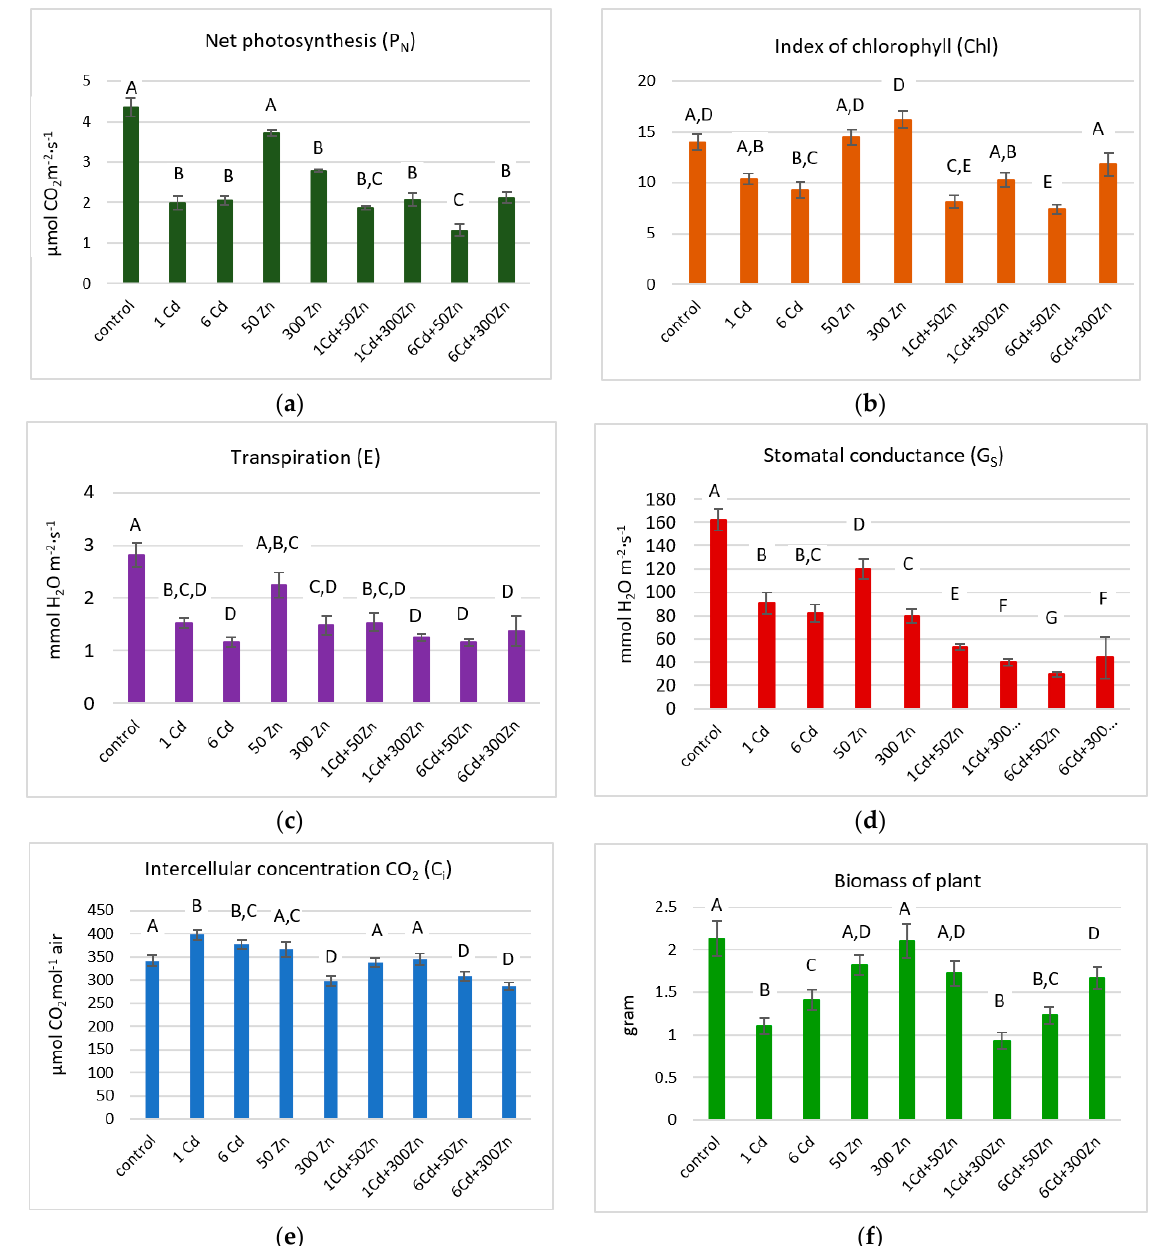
Figure 1. Net photosynthesis ( a ), index of chlorophyll ( b ), transpiration ( c ), stomatal conductance ( d ), intercellular concentration CO 2 ( e ), and biomass of lemon balm plants ( f ) with relevant standard deviations ( n = 5). Specific letters illustrate the statistically significant differences as computed with the Tukey’s HSD test ( p = 0.95). Symbols on the horizontal lines represent Zn and Cd supplementations: (1Cd)-1 µg/g; (6Cd)-6 µg/g; (50Zn)-50 µg/g Zn; (300Zn)-300 µg/g Zn; (1Cd + 50Zn)-1 µg/g Cd and 50 µg/g Zn; (1Cd + 300Zn)-1 µg/g Cd and 300 µg/g Zn; (6Cd + 50Zn)-6 µg/g Cd and 50 µg/g Zn; (6Cd + 300Zn)-6 µg/g Cd and 300 µg/g Zn.